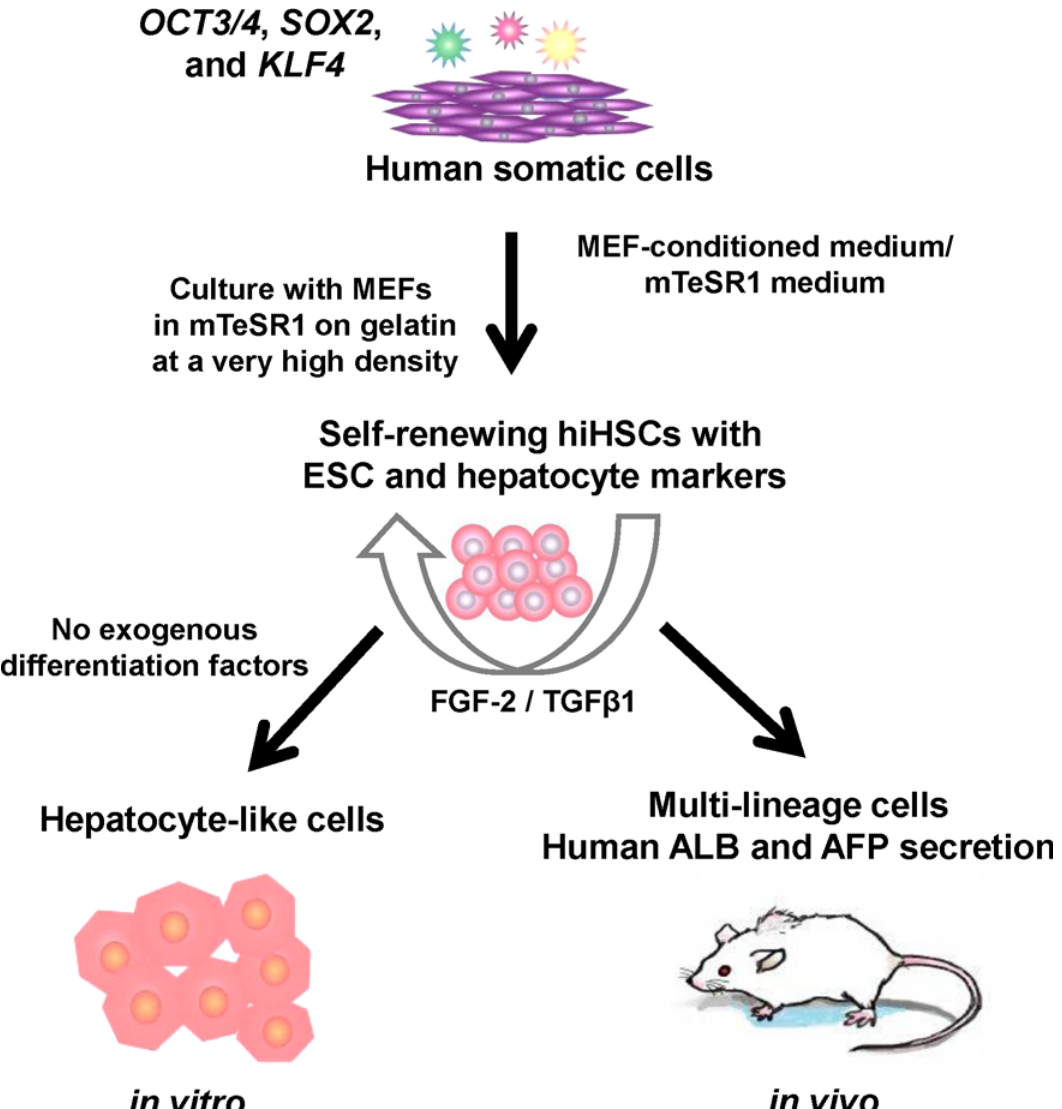
Fig 5. Generation, self-renewal, and differentiation of hiHSCs. Generation, self-renewal, and differentiation of hiHSCs were schematically illustrated. hiHSCs were generated and expanded as a new type of hiPSC from human somatic cells by gene transfer of defined factors and with some modifications of their culture conditions. The autonomous hepatic specification of hiHSCs was due to their culture conditions (coculture with MEF in mTeSR1 medium at a very high density) in self-renewal rather than in differentiation. Self-renewing hiHSCs expressed markers of both hESCs and hepatocytes and then autonomously differentiated to hepatocyte-like cells in a defined minimum medium without FGF-2 and TGF- β 1in vitro. Otherwise, in vivo differentiated hiHSCs gave rise not only to hepatocyte-like cells but also to other multi-lineage cells and then secreted human ALB in